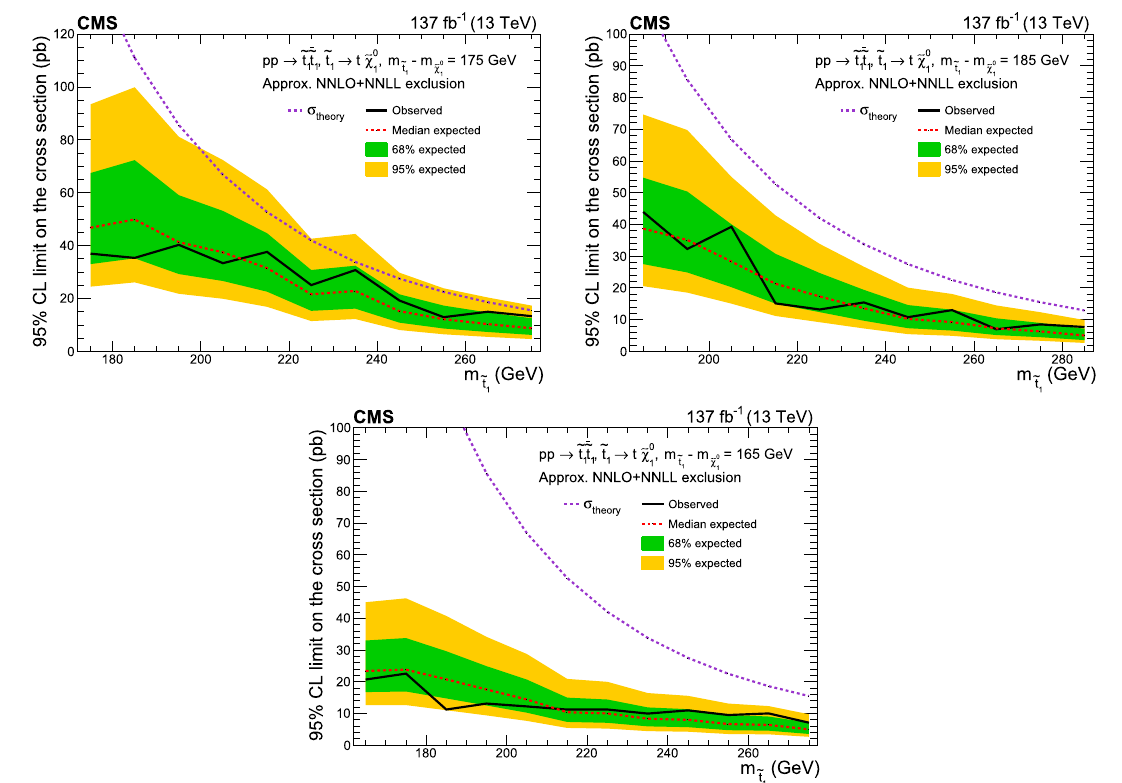
Fig. 8 Upper limit at 95% CL on the signal cross section as a func- tion of the top squark mass for Δ m 185GeV(upperright)and165GeV(lower).Thegreenandyellowbands